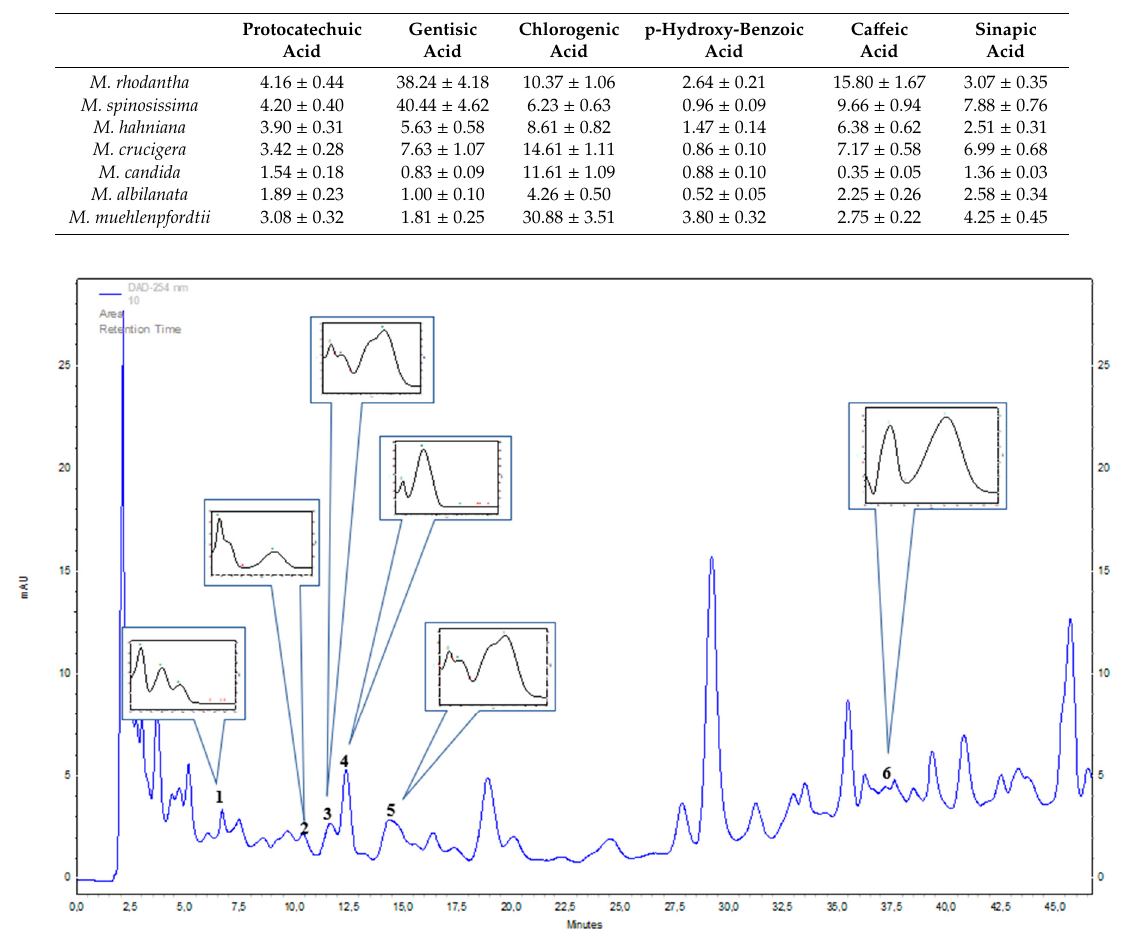
Figure 1. Representative HPLC-DAD ( λ = 254 nm) chromatogram of Mammillaria pringlei stem extracts: 1—protocatechuic acid, 2—gentisic acid, 3—chlorogenic acid, 4—p-hydroxybenzoic acid, 5—caffeic acid, 6—sinapic acid.